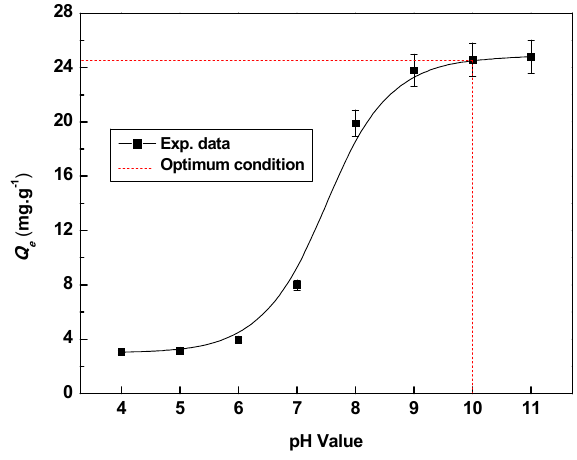
Figure 8. The Q e —pH value curve with adsorption of 0.1 g HMO in 50 mg·L − 1 Li + at 18 °C.